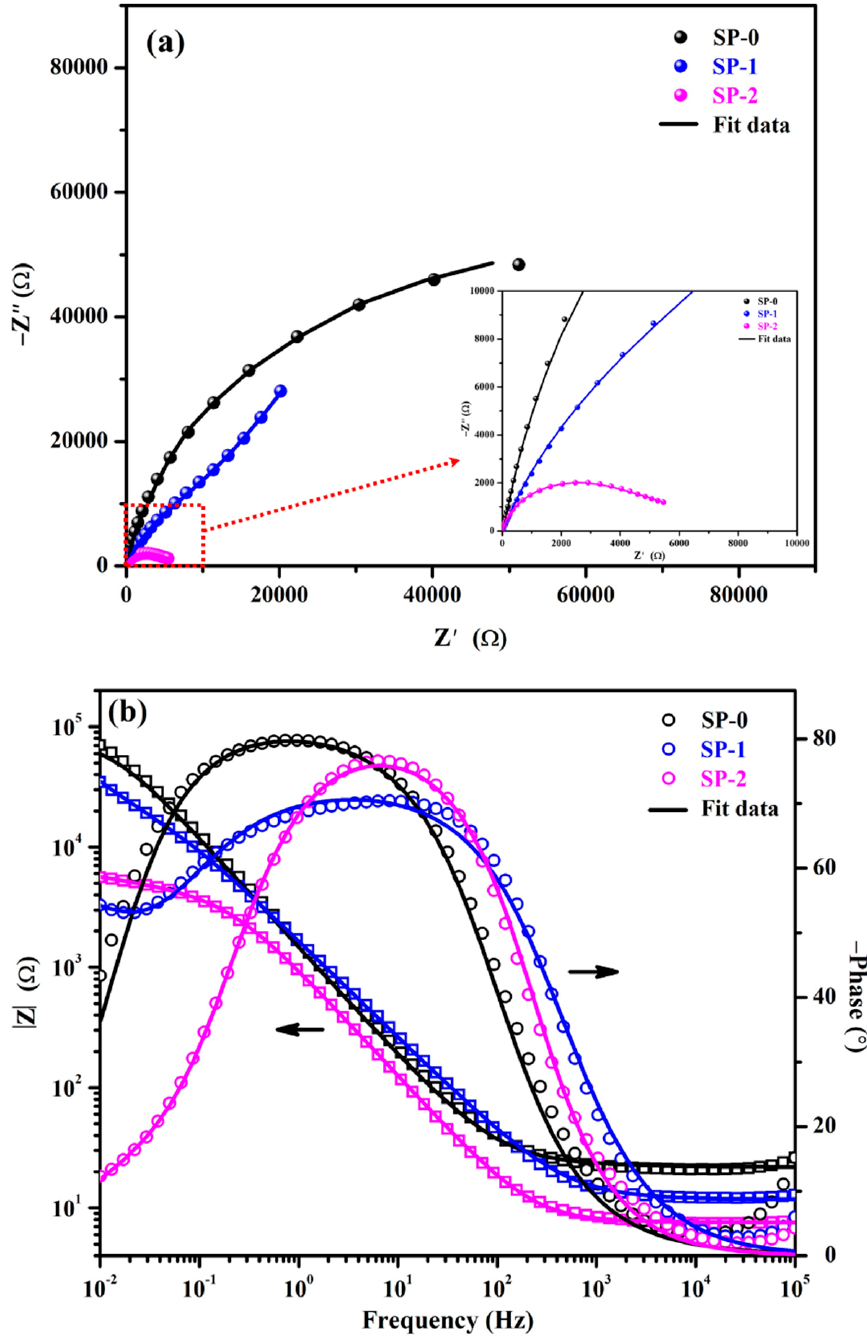
Figure 3. EIS plots for ( a ) Nyquist and ( b ) Bode spectra after 48 h of exposure.